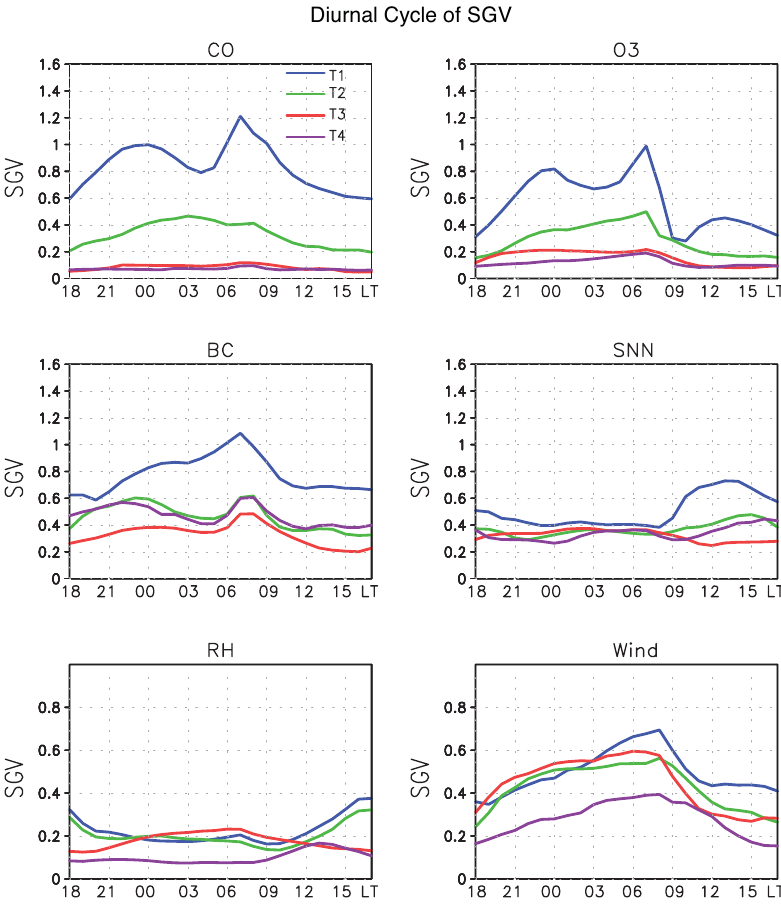
Fig. 13. Diurnal variation of SGV for CO, O3, BC, SNN, RH, and wind speed at the surface for sites T1, T2, T3, and T4. The SGV is calculated over the time period 5–30 March